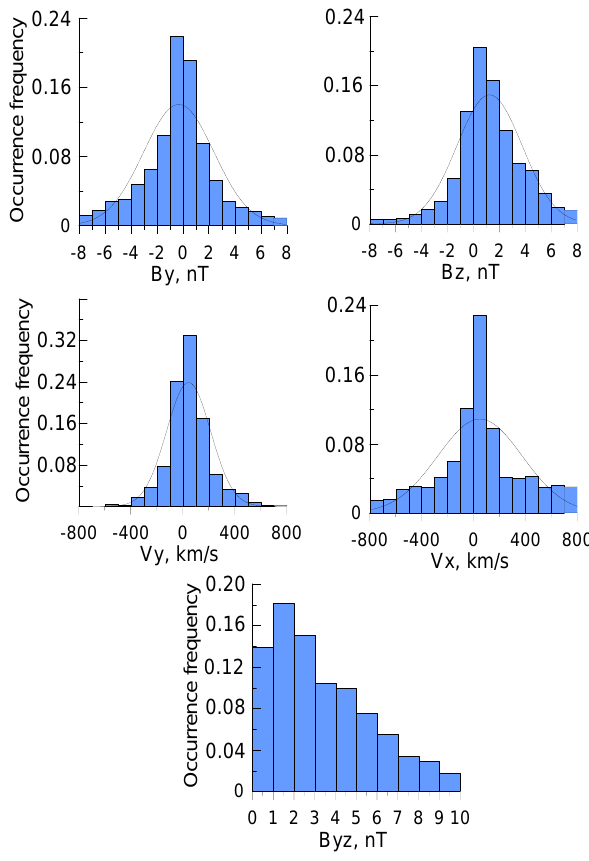
Fig. 4. Normalized occurrence frequency distributions of magnetic field and plasma flow velocity components in the neutral sheet dur- ing fast plasma sheet crossings (their Gaussian fits are also shown). B yz = (By 2 + Bz 2 ) 1 / 2 ) is the magnetic field in the neutral